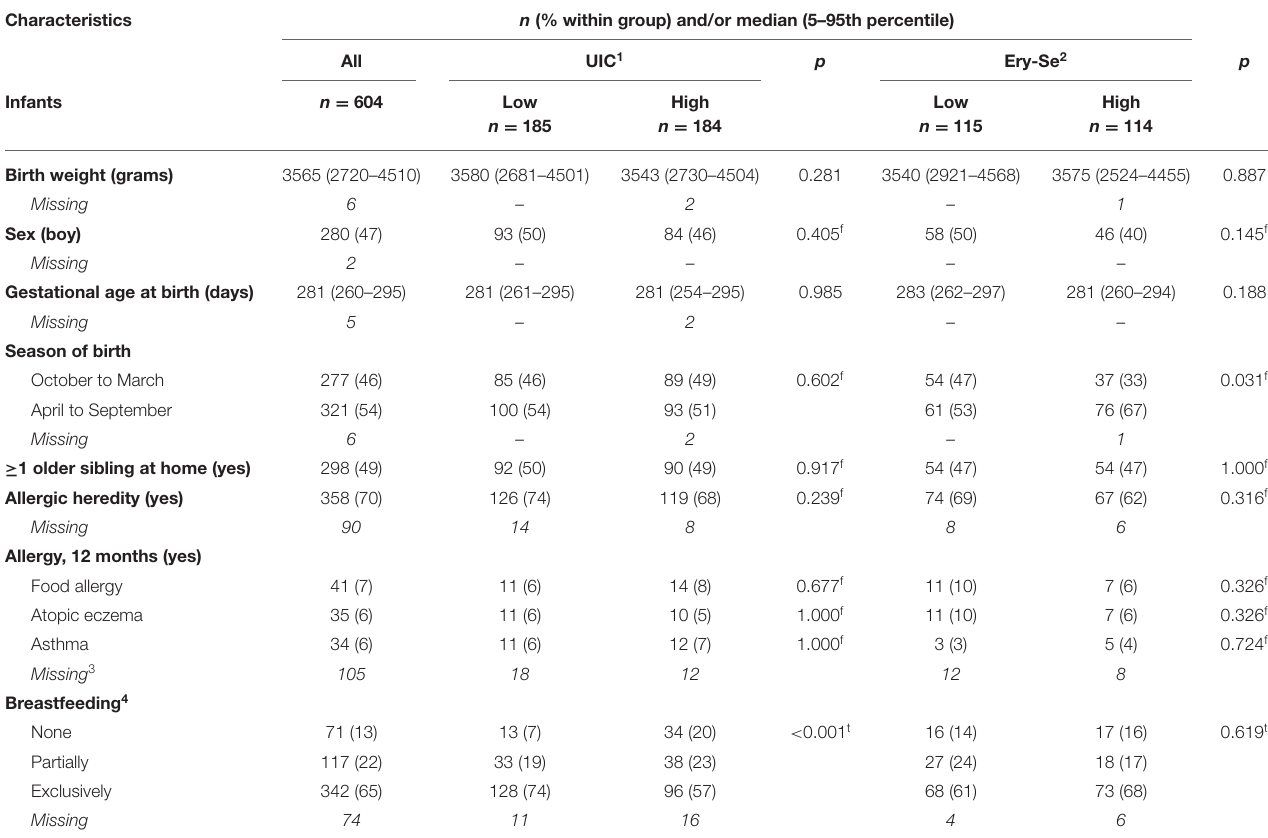
TABLE 2 | Characteristics of included infants categorized by low and high (median split) iodine (urinary concentrations, UIC) and selenium (erythrocyte concentrations, Ery-Se) status.